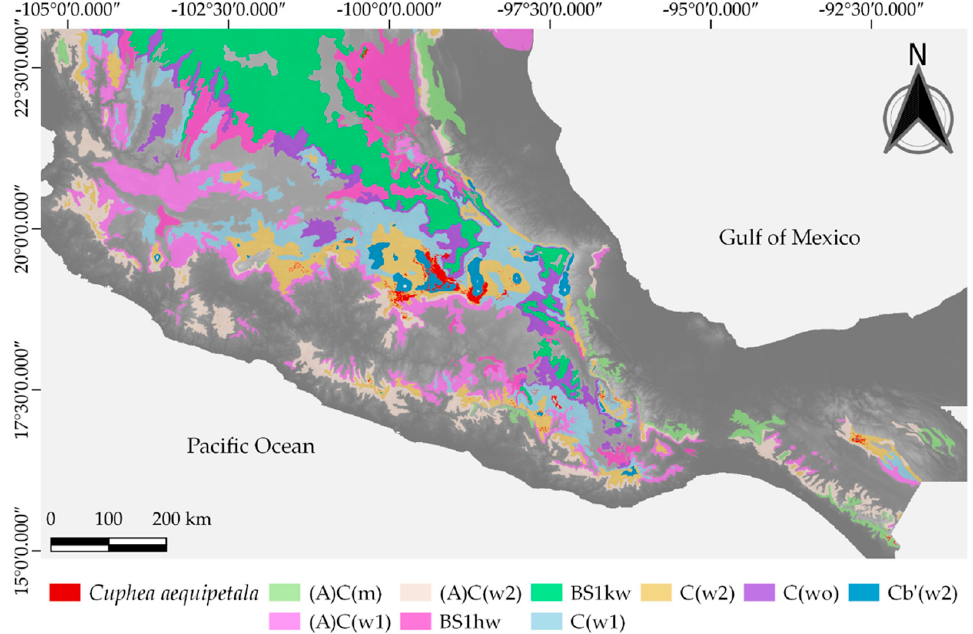
Figure 6. Contrast analysis by overlapping the potential distribution of Cuphea aequipetala Cav. with